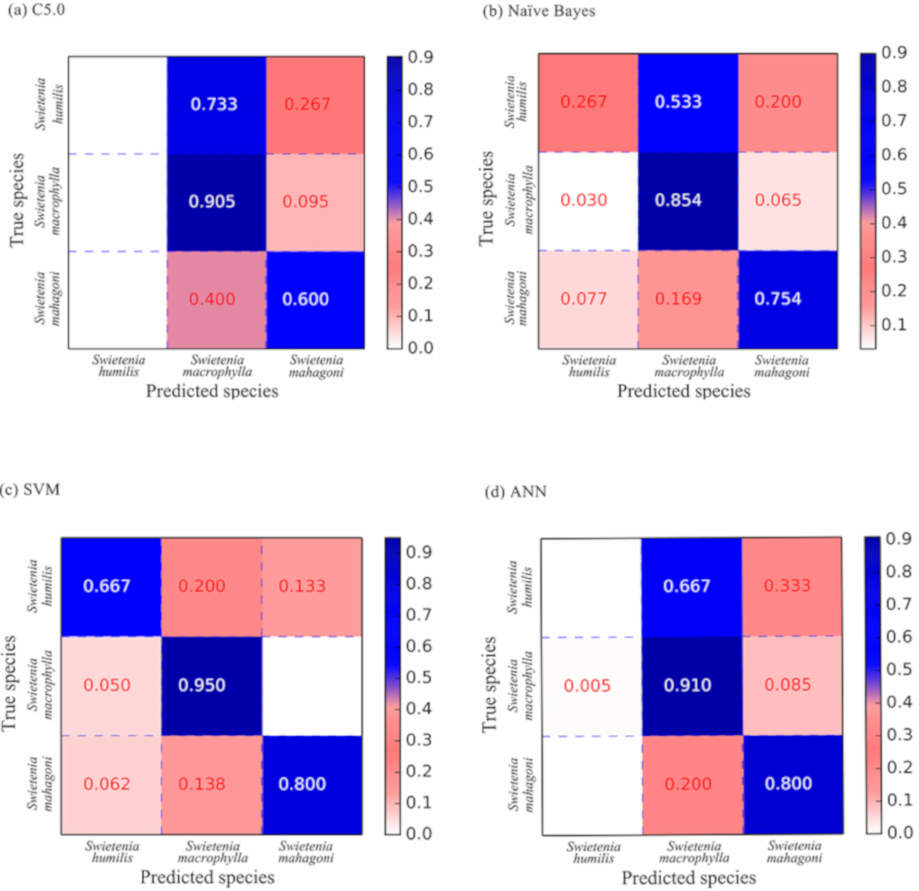
Figure 3. Confusion matrices generated by the four supervised classifiers: ( a ) Decision Tree C5.0, ( b ) Naïve Bayes, ( c ) Support Vector Machine, ( d ) Artificial Neural